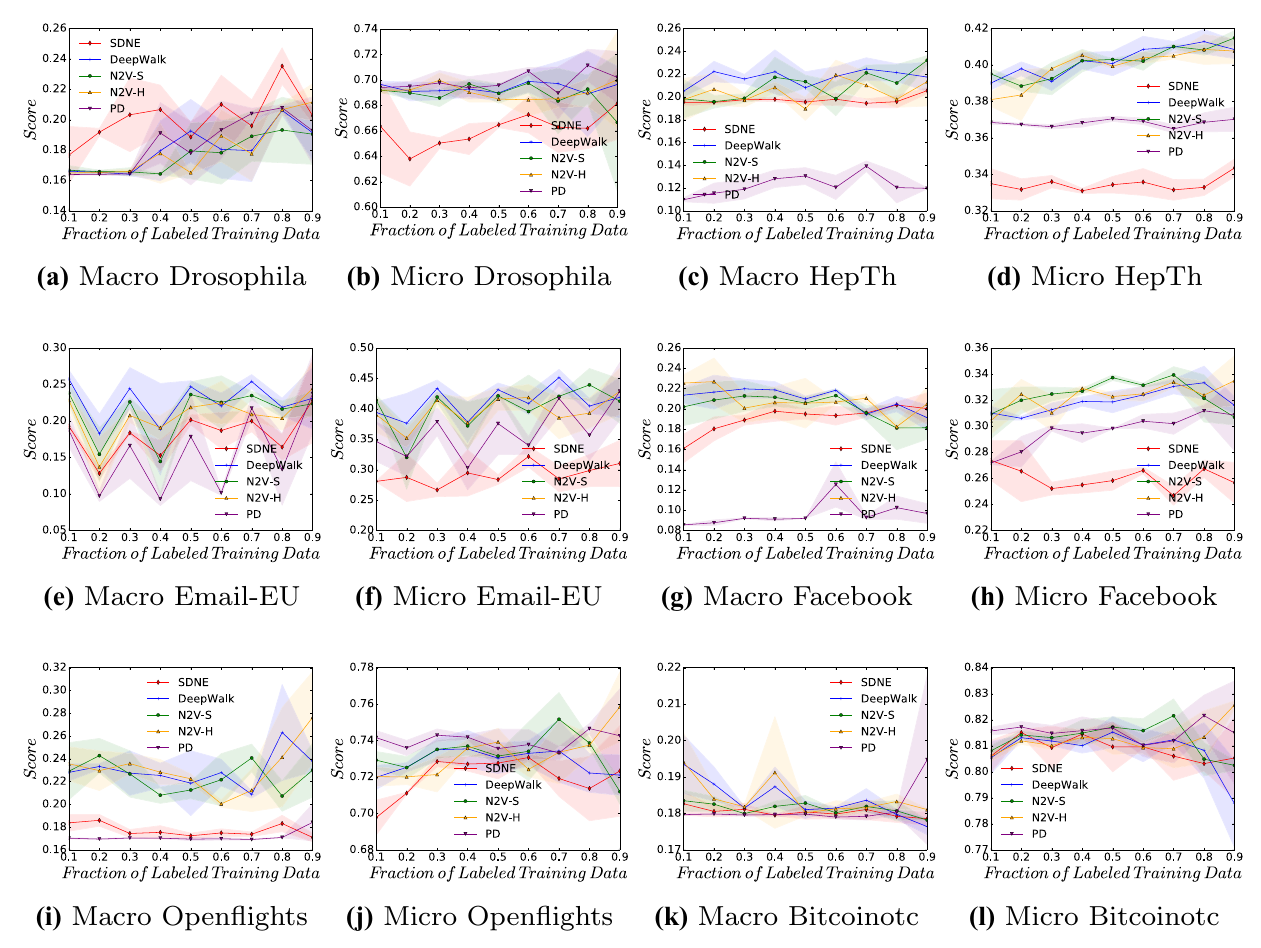
Fig. 2 Micro- and macro-f1 scores, across a range of labelling fractions, for all approaches when predicting a vertex’s degree (DG) value across all